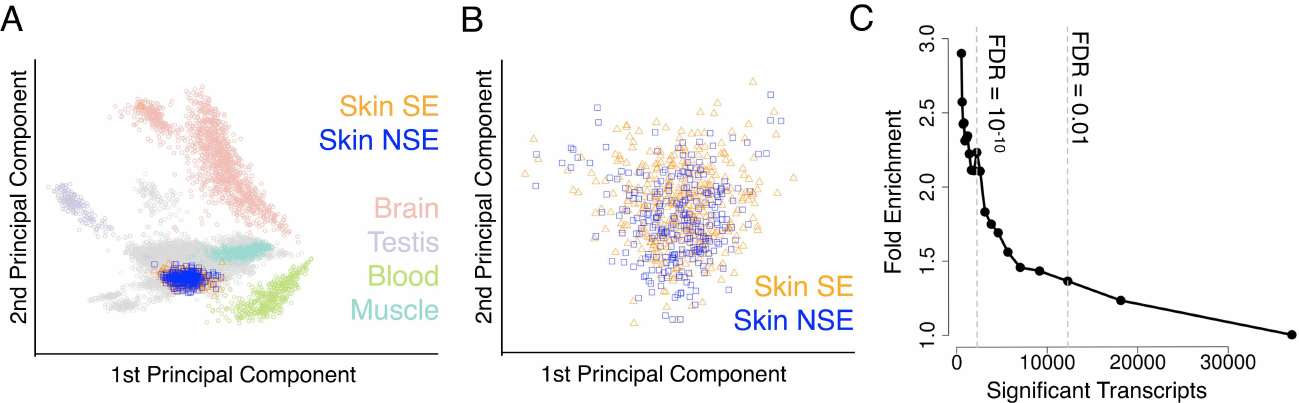
Fig 1. Sun-exposed and non-sun-exposed skin samples. (A) First and second principalcomponentsof all GTEx samples with selected tissue- types highlightedby color. (B) First and second principal components using all genes in only the skin samples. (C) Fold enrichment of 2-fold differentially expressed genes from Choi et al . [43] as a function of the stringency in callingdifferentially expressed genes from the GTEx